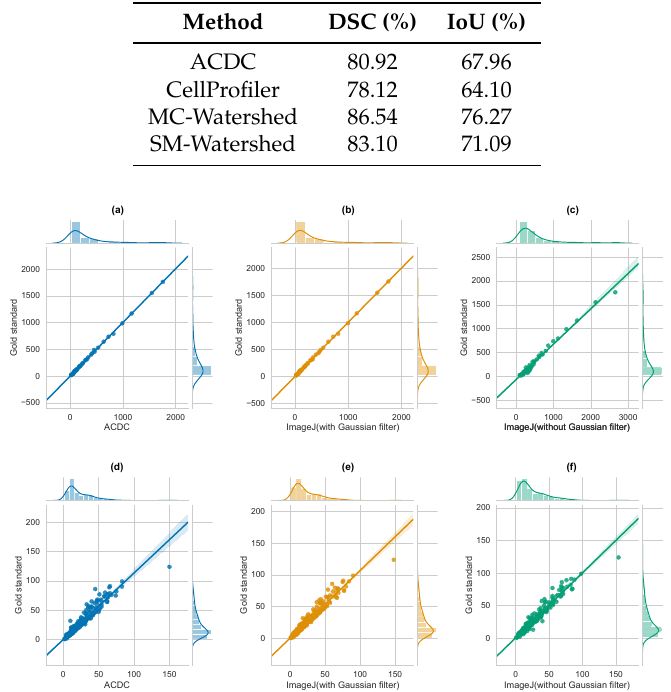
Figure 11. Regplots showing the scatter plots obtained by considering the number of manually detected cells (y-axis) and the number of cells automatically detected (x-axis) with ACDC (left), ImageJ with Gaussian filter (center), and ImageJ without Gaussian filter (right), along with the fitted regression model (regression line and the 95% confidence interval for that regression). Plots ( a – c ) report the results obtained on the VU dataset, while plots ( d – f ) are obtained from the DSB dataset.